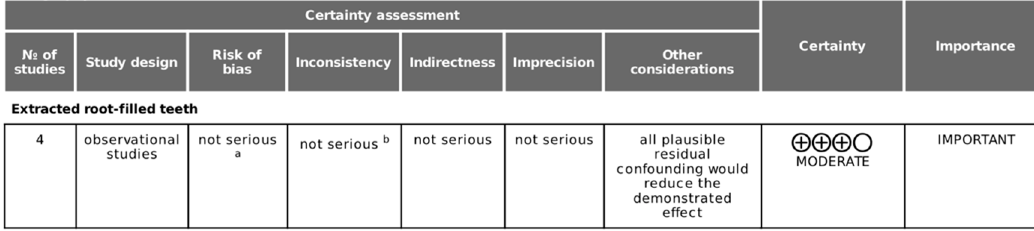
Figure 5. Risk of bias summary of studies included according to the Cochrane Collaboration’s tool for assessing risk of bias. + Low risk of bias. − High risk of bias. ? Unclear risk of bias.